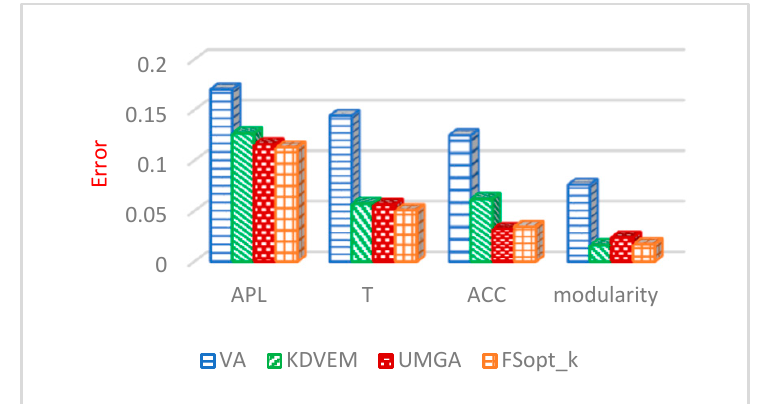
Figure 12. Average of the obtained error values on all datasets .